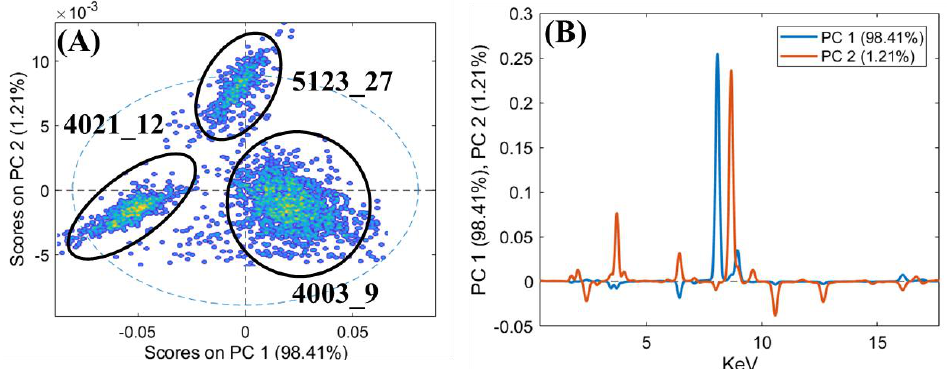
Figure 11. PCA score plot of the XRF spectra ( A ) and the loadings of PC1 and PC2 ( B ) for the zoomorphic fibula (4021_12), the applique (4003_9), and the spatula (5124_27).